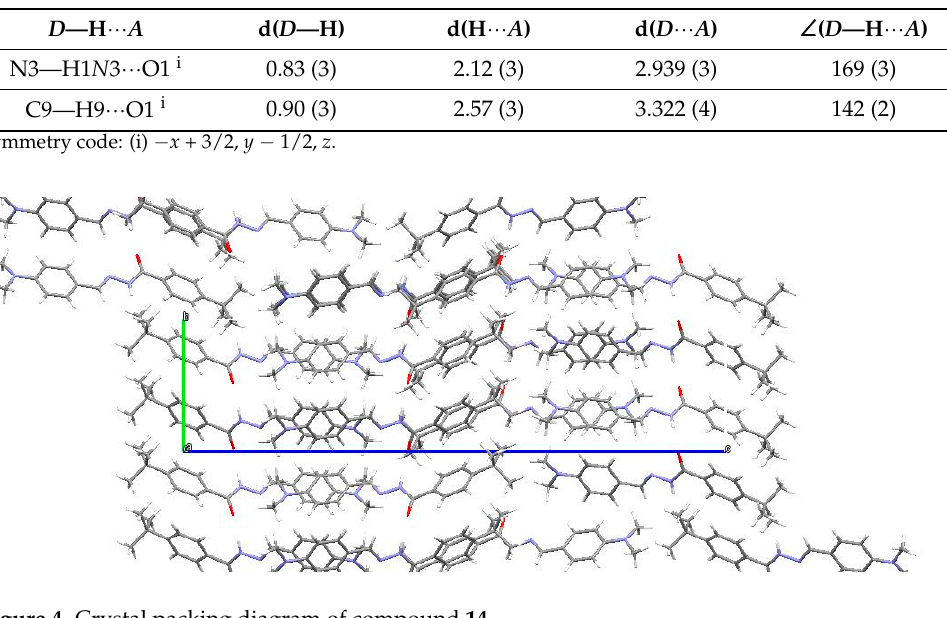
Table 6. Hydrogen-bond geometry with bond lengths (Å) and bond angles ( ◦ ).